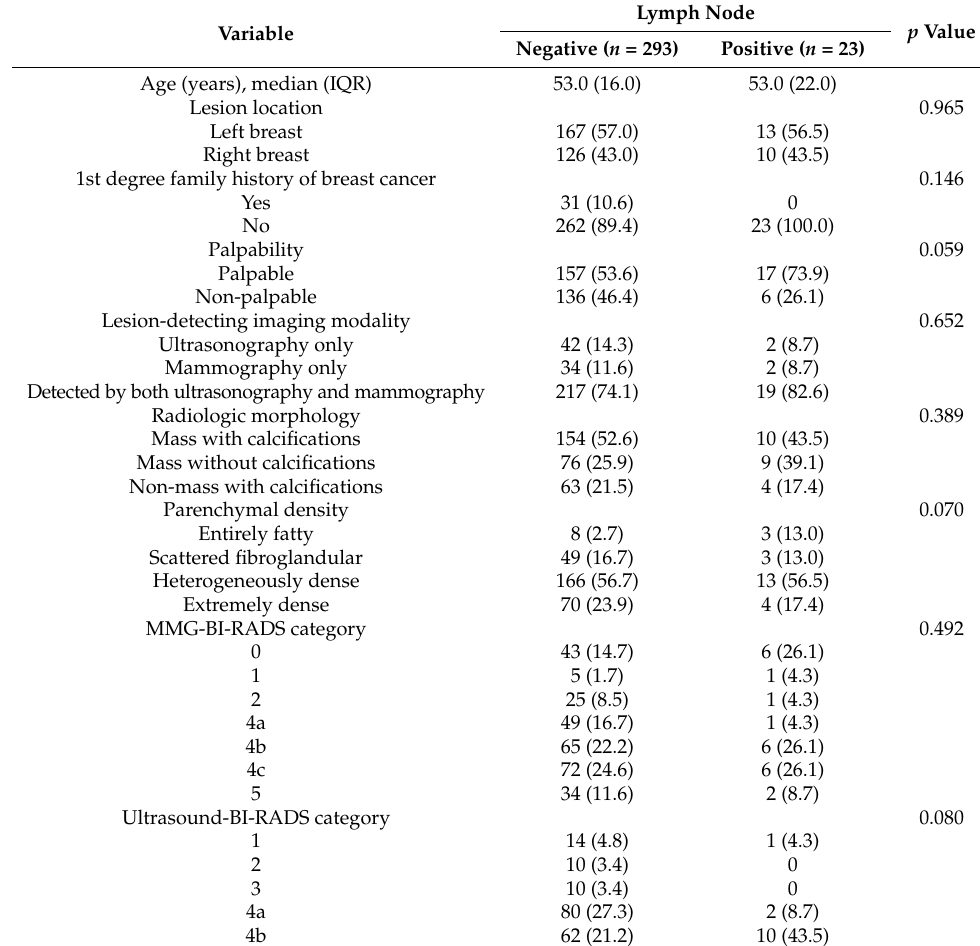
Table 3. Univariate analysis of factors influencing the lymph node status in underestimated invasive breast. Carcinoma patients with initial diagnosis of ductal carcinoma in situ by image-guided core needle